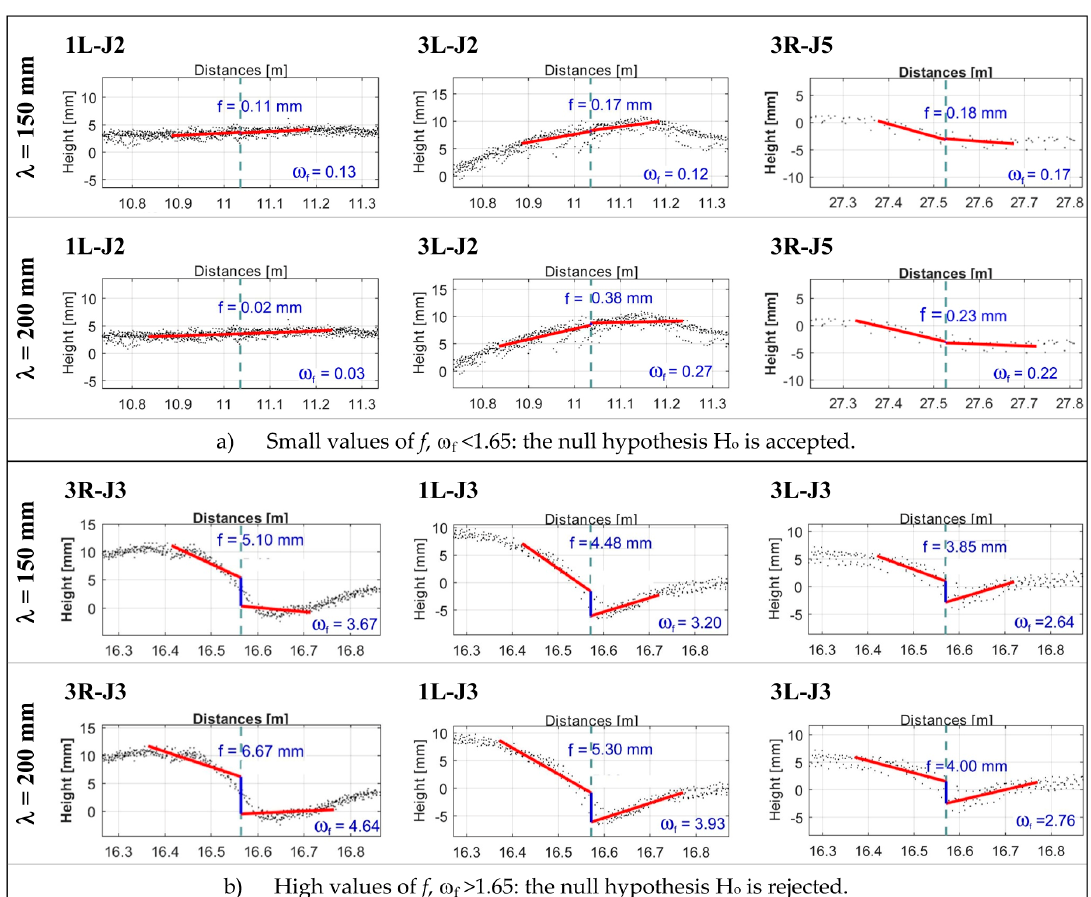
Figure 12. Display of the faulting values computed using the segments interpolating the point clouds for strips of 150 + 150 mm (upper panels) or 200 + 200 mm (lower panels) over the joints. Most of the time, the use of λ = 200 mm leads to an increase in the number of cases where the measured value is significantly different from zero and therefore indicative of a step actually present among the slabs along the section considered. Obviously, it should be underlined that, although significant, the evaluated value for the step height can be so small that it does not give rise to any alarm and consequent action. The method we proposed selects those measured values that could be reasonably compared with the alarm threshold.